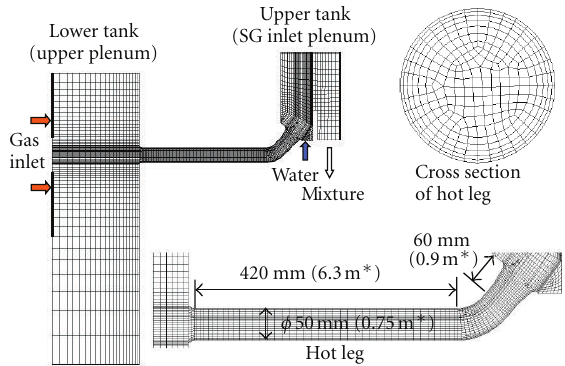
Figure 3: Computational grid ( ∗ full